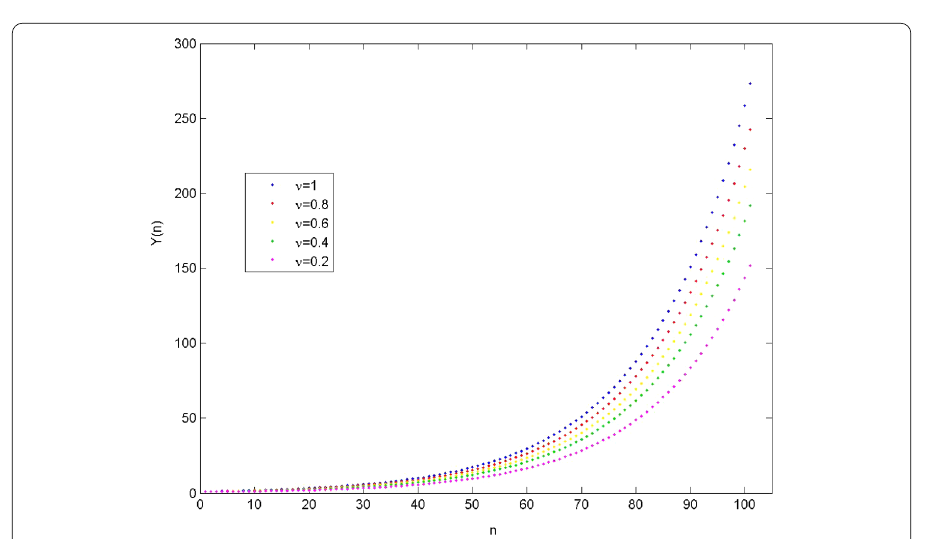
Figure 1 Solutions for λ = 0.1, μ = 0.8 and different values of